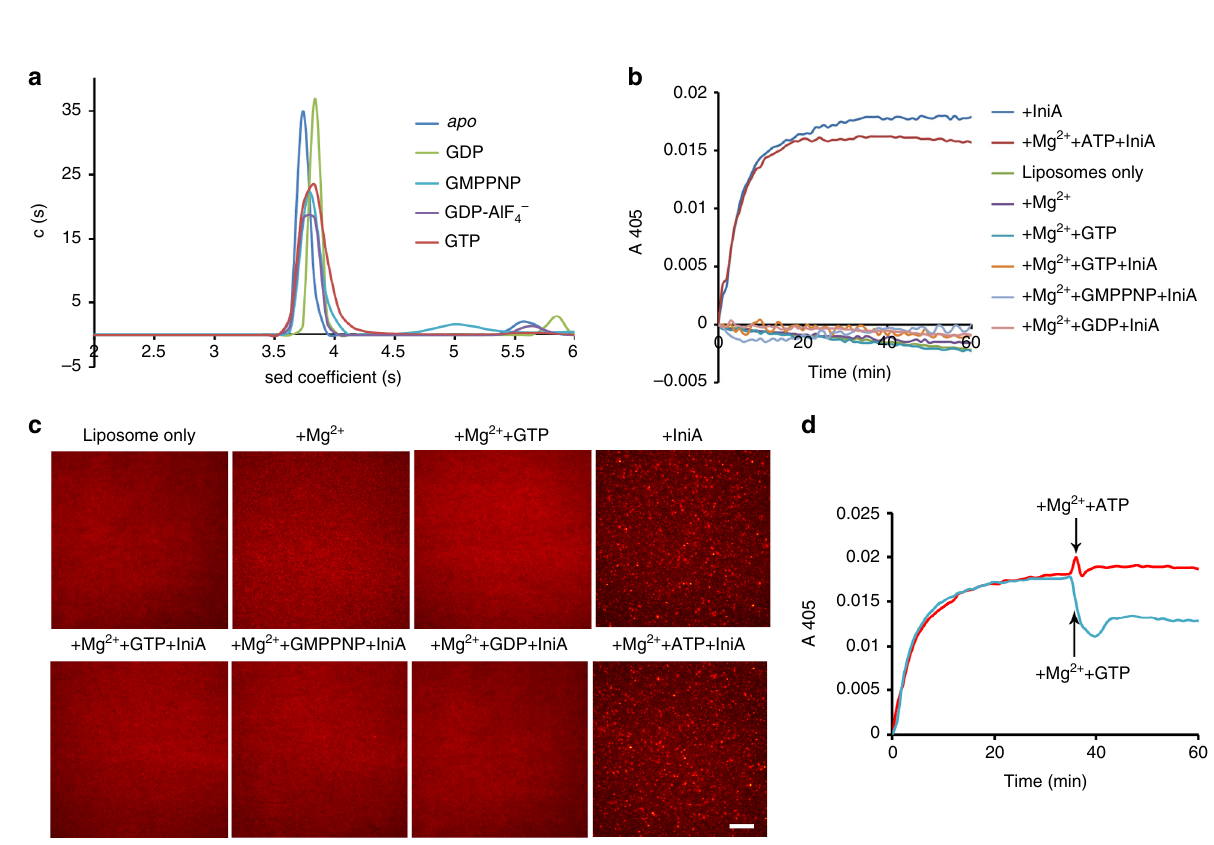
Fig. 4 Nucleotide-independent oligomerization. a The molecular masses of IniA (theoretical molecular mass 65.9 kDa) were determined from sedimentation coef fi cients measured by analytical ultracentrifugation in the absence or presence of 2 mM GDP/GMPPNP/GTP or 2 mM GDP, 5 mM AlCl 3 ,10 mM NaF. The data are representative of at least three repetitions. b Liposomes (78 mol% PE, 12 mol% PG, 6 mol% CL, 4 mol% PA, fi nal lipid concentration 2 mM) were mixed in various conditions, 2 μ M IniA was added at initiation, and the absorbance was measured at 405 nm. The data are representative of at least three repetitions. c As shown in ( b ), the results were observed using a fl uorescence microscope. Scale bar, 40 µ m. d As shown in ( b ), 2 mM Mg 2 + and 5 mM GTP (or 5 mM ATP as a control) were added after a period of reaction. The source data of Figs. 4a, b and d are provided in the